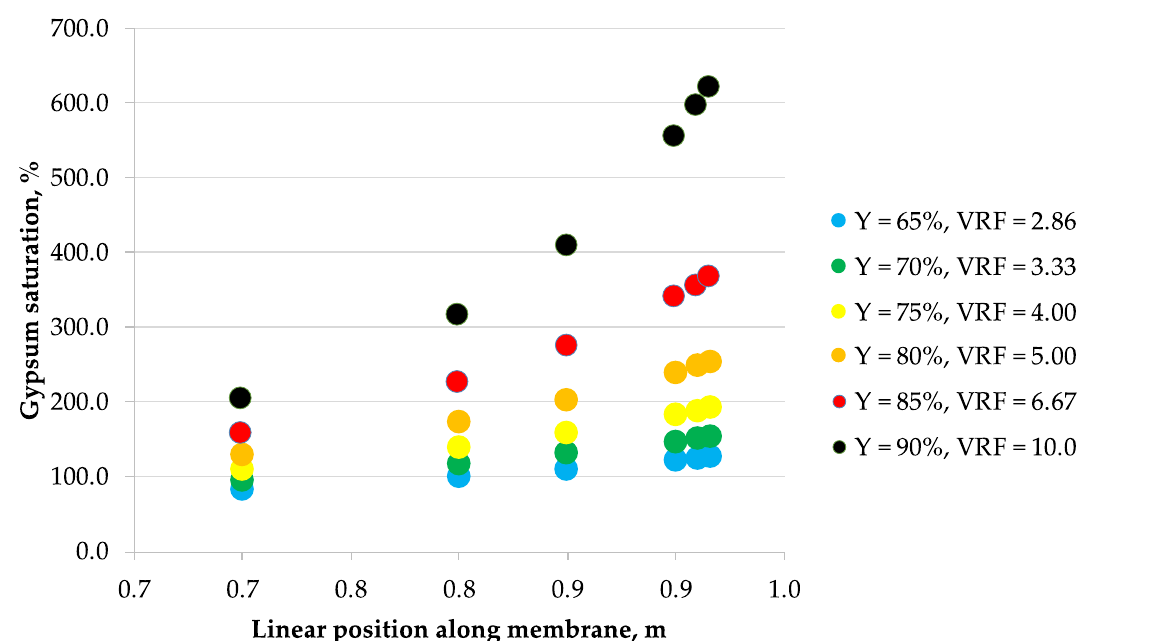
Figure 5. Saturation vs. position along the membrane for mine water B (33.2 g/L as Cl − , 0.937 g/L as SO 42 − , 19.5 g/L as Na + , 0.990 g/L as Mg 2+ , 0.771 g/L as Ca 2+ ) and NFX nanofiltration membrane.